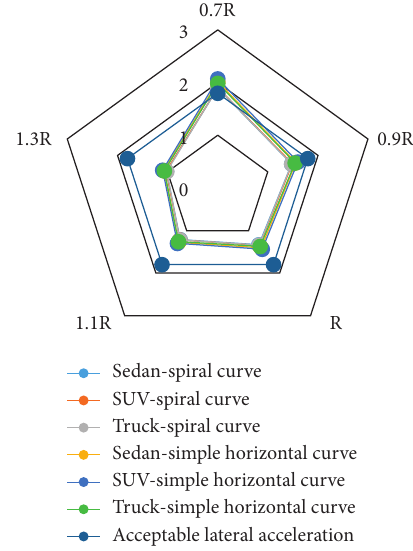
Figure 10: Maximum lateral acceleration in simple and spiral horizontal curves for various radii and vehicle types, and the speed of 100